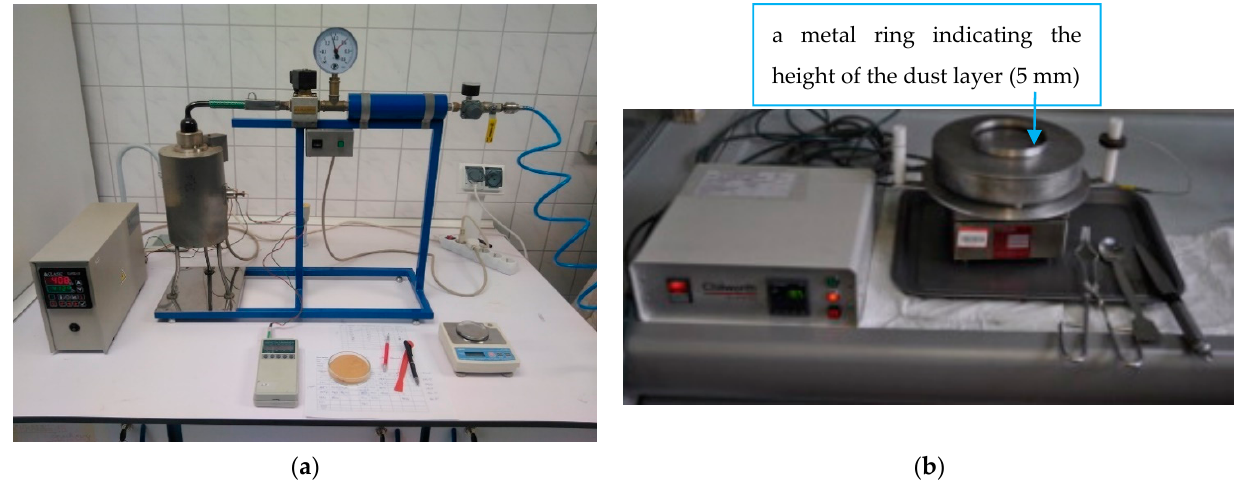
Figure 2. ( a ) The test equipment for the measurement of the minimum ignition temperature of airborne dusts; ( b ) experimental equipment “hot-plate” from [39].